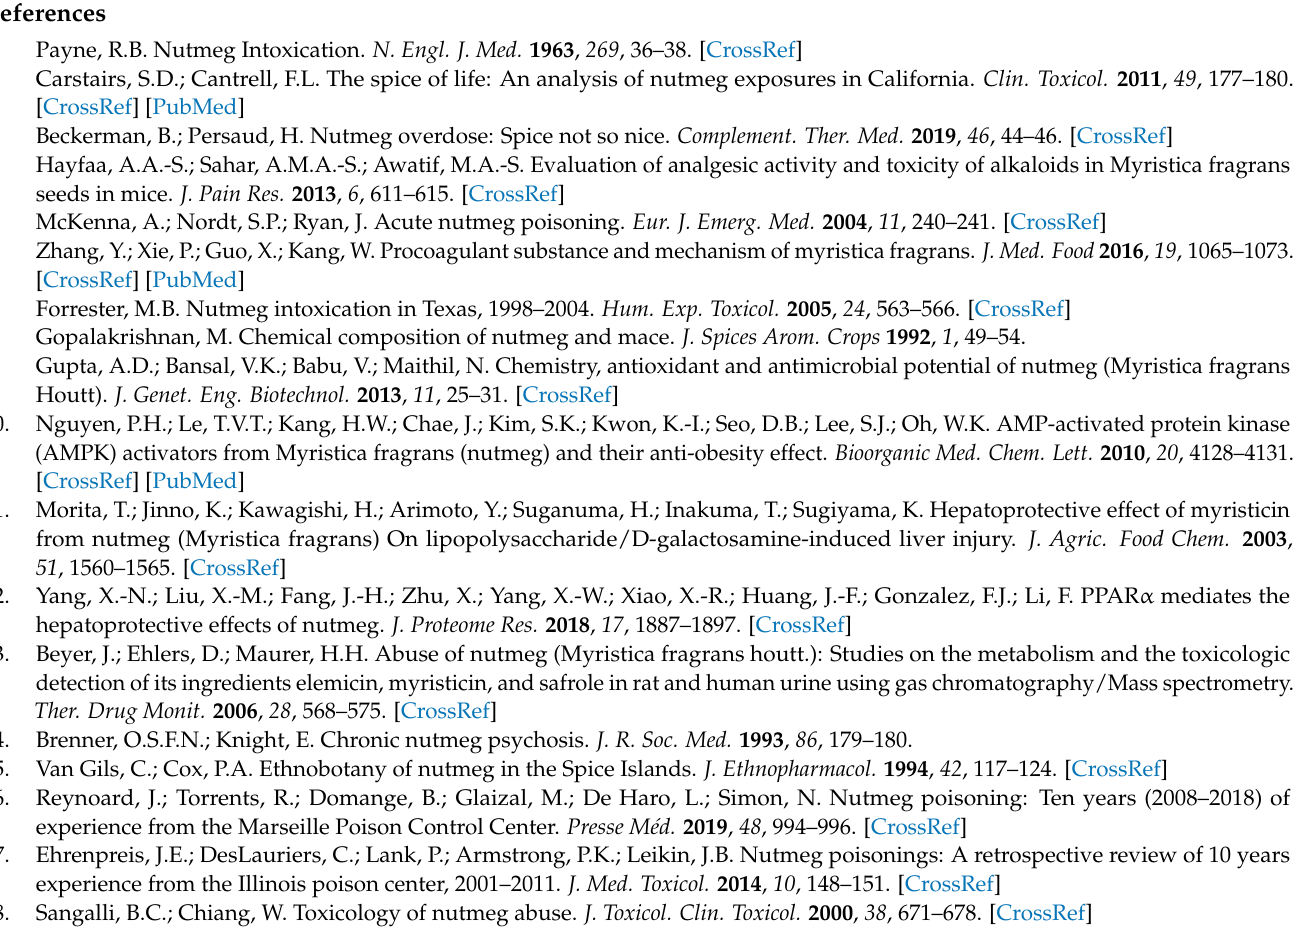
Supplementary Materials: The following are available online. Figure S1: The protein quality test by SDS-PAGE gel electrophoresis, Table S1: Peptide fraction separation liquid chromatography elution gradient table, Table S2: Liquid chromatography elution gradient table, Table S3: The analysis parameter of Proteome Discoverer 2.2, Table S4: The DEPs between the low-dose group and the control group, Table S5: The DEPs between the high-dose group and the control group, Table S6: The DEPs between the low-dose group and the high-dose group. Table S7: The major discussed DEPs after nutmeg exposure and their KEGG